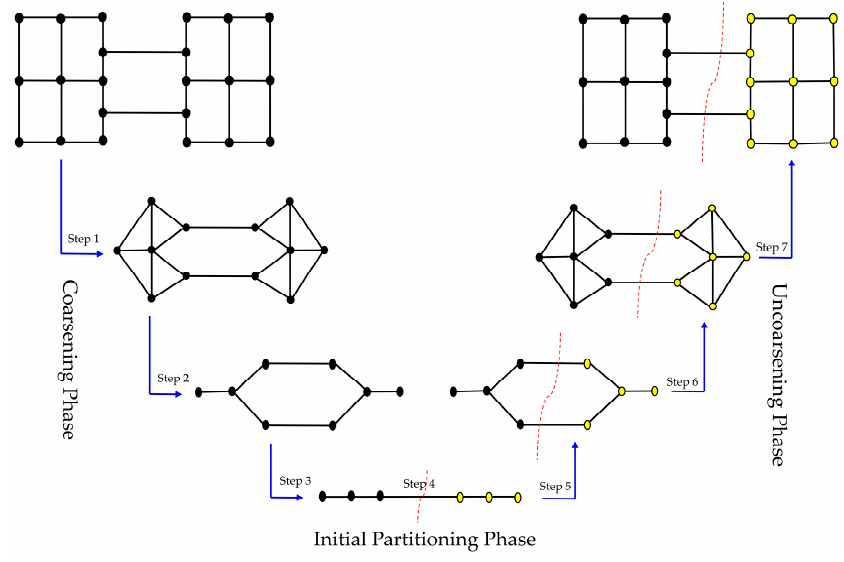
Figure 5. Di ff erent phases of a multi-level recursive bisection algorithm Figure 5. Different phases of a multi-level recursive bisection algorithm [72].